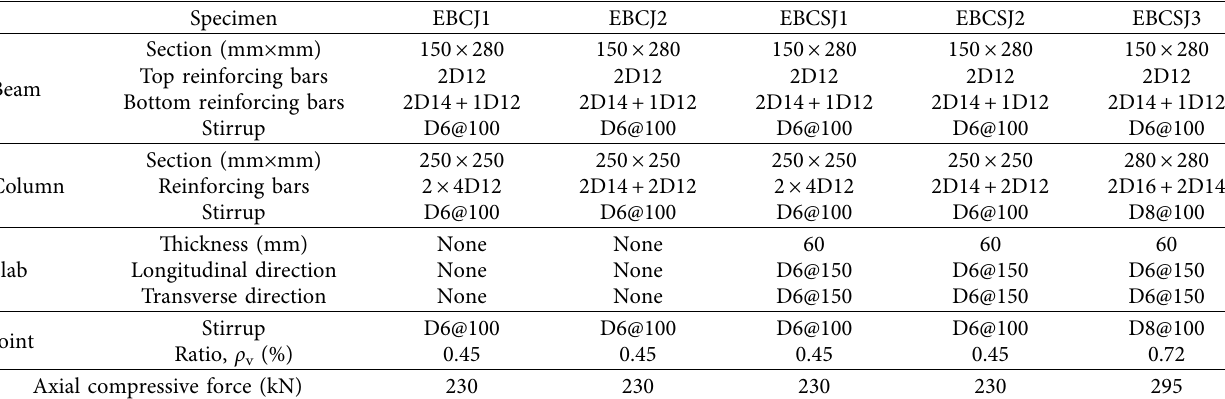
Figure 1: Details of the reinforcement layout in the specimens (dimensions are in mm; D Table 1: Main design parameters and important values.